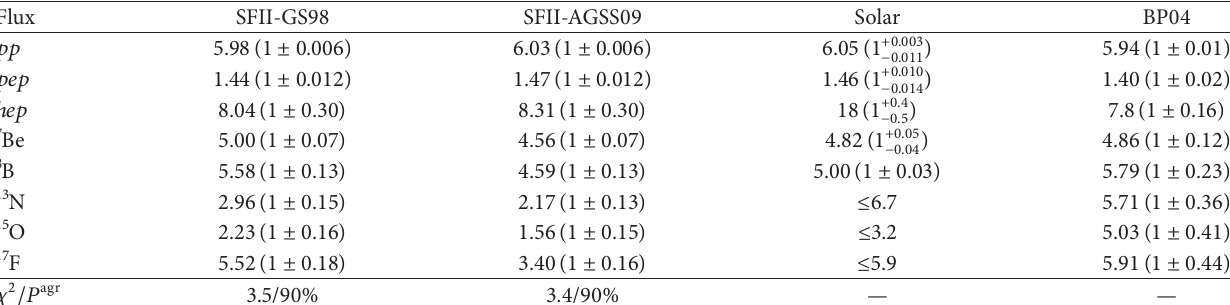
Table 4: SSM predictions for solar neutrino fluxes (second and third columns) and solar neutrino fluxes (fourth column) inferred from all available neutrino data. Units are, in cm −2 s −1 , as usual: 10 10 (𝑝𝑝) , 10 9 ( 7 Be), 10 8 ( 𝑝𝑒𝑝 , 13 N, 15 O) 10 6 ( 8 B, 17 F), and 10 3 (ℎ𝑒𝑝) . Note that the limit on the fluxes relative to the CNO cycle do not contain yet the information coming from recent Borexino result [74]. A revised analysis including these data is in